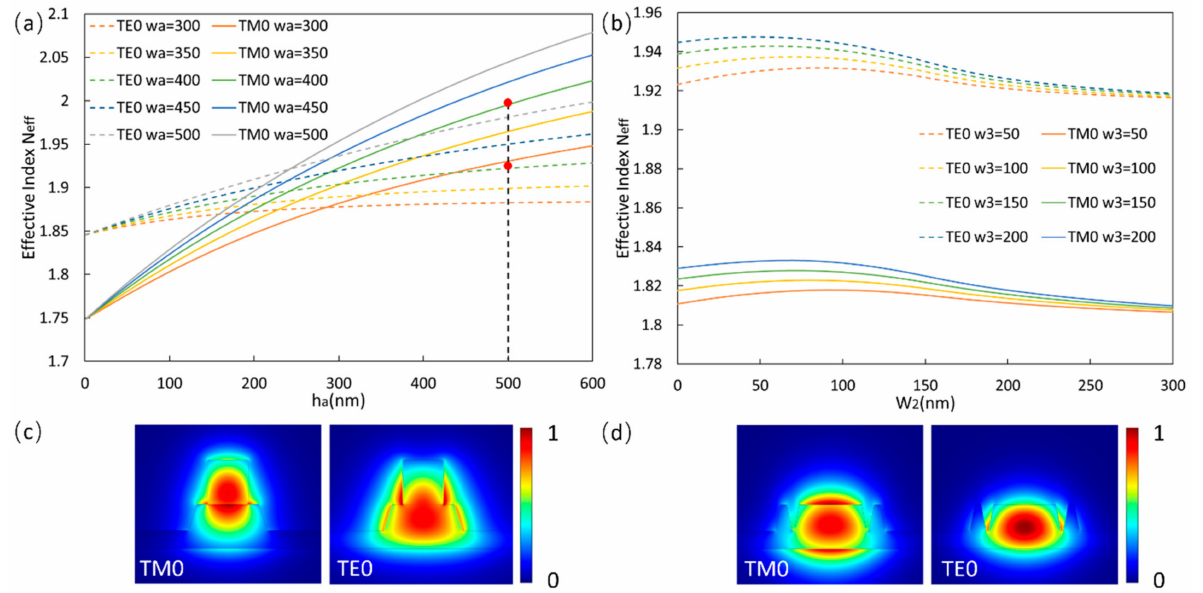
Figure 2. ( a ) Calculated effective indices of TE 0 and TM 0 modes in Si 3 N 4 assisted LN WGs as a func- tion of ha for different w a . ( b ) Calculated effective indices of TE 0 and TM 0 modes in grooved LN WGs as a function of w 2 for different w 3 . ( c ) Electrical field profiles for TM 0 mode (w a , h a ) = (400, 500) nm, TE 0 mode (w a , h a ) = (400, 500) nm. ( d ) Electrical field profiles for TM 0 mode (w 2 , w 3 ) = (200, 100) nm, TE 0 mode (w 2 , w 3 ) = (200, 100) nm.